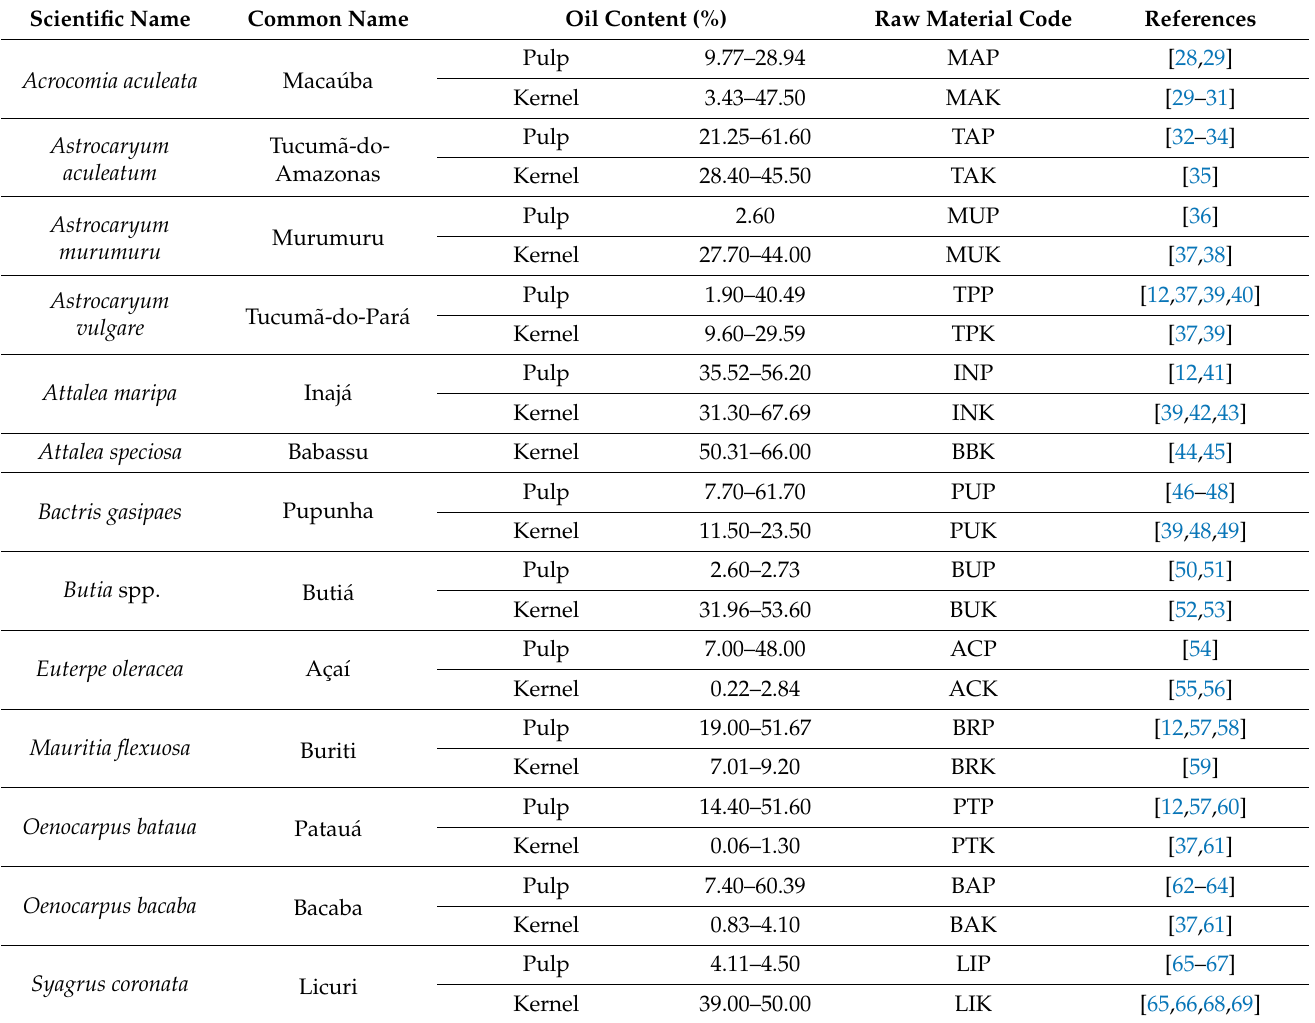
Table 1. Nomenclature and oil content of emerging Arecaceae